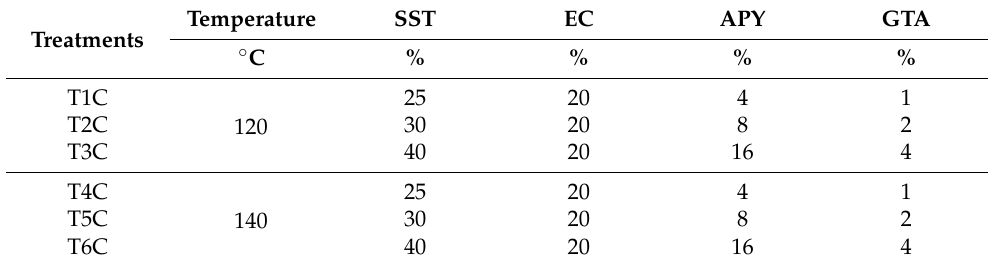
Table 1. Erythrocyte encapsulation treatments.